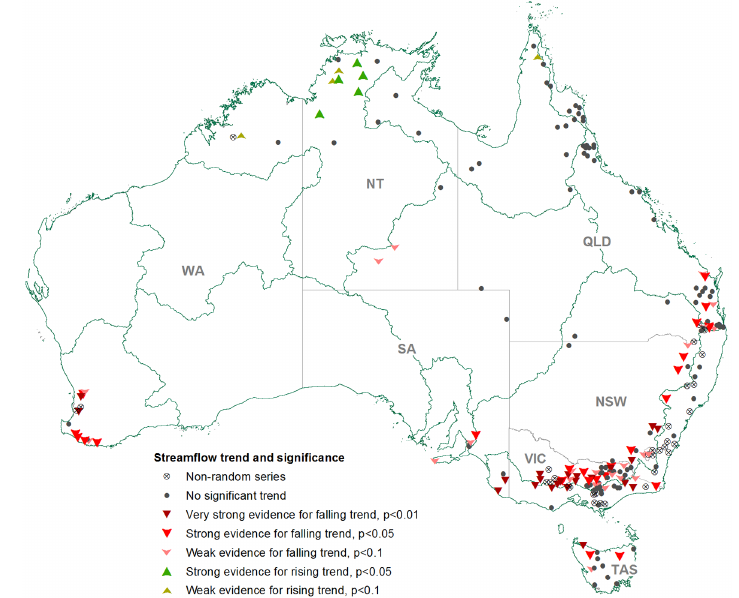
Figure 5. Spatial variation in trend results of annual total flow ( Q T ); trends were shown in significance levels at 0.01, 0.05 and